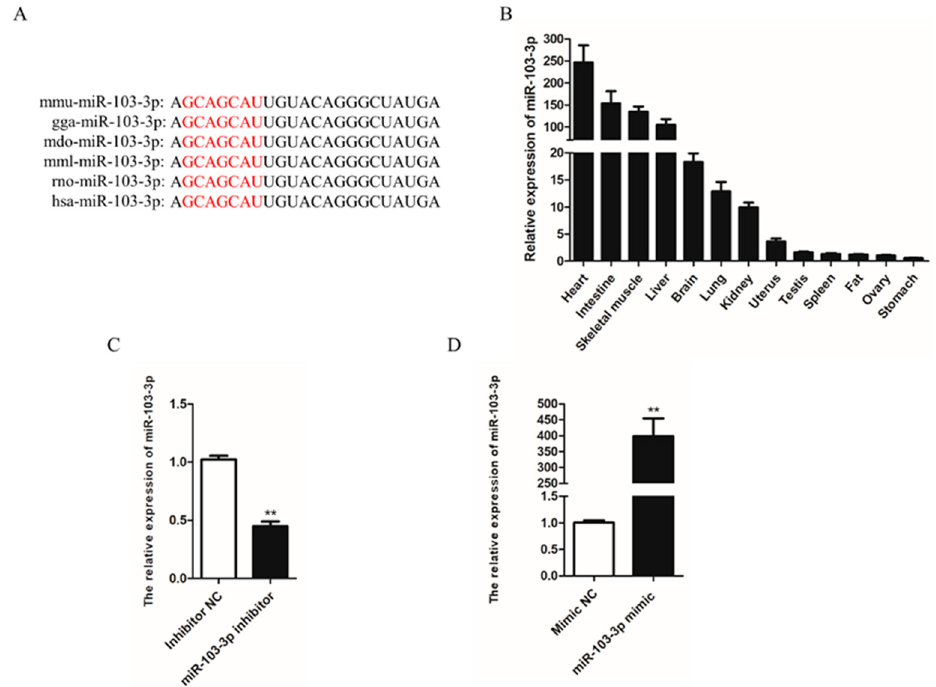
Figure 1. Expression of miR-103-3p in mouse tissues. ( A ) miR-103-3p sequence of different species: mmu, mice; gga, chicken; mdo, Monodelphis ; mml, Macaca mulatta ; rno, rat; hsa, Homo sapiens . The seed sequence of miR-103-3p is shown in red. ( B ) Expression of miR-103-3p in different mouse tissues. Skeletal muscle was uniformly collected from the gastrocnemius muscle of the right calf from three mice. ( C , D ) The expression of miR-103-3p in C2C12 cells was detected by qRT-PCR after transfection with the miR-103-3p inhibitor or mimic. n = 3, ** p < 0.01.